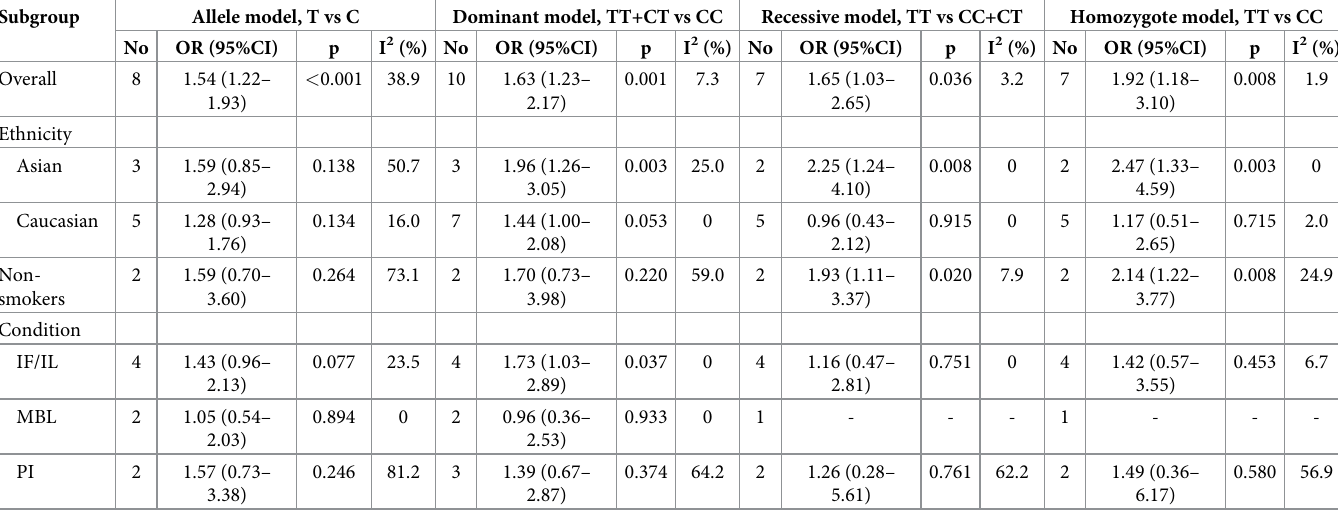
Table 2. Association between IL-1 α C-899T polymorphism and susceptibility to peri-implant disease.